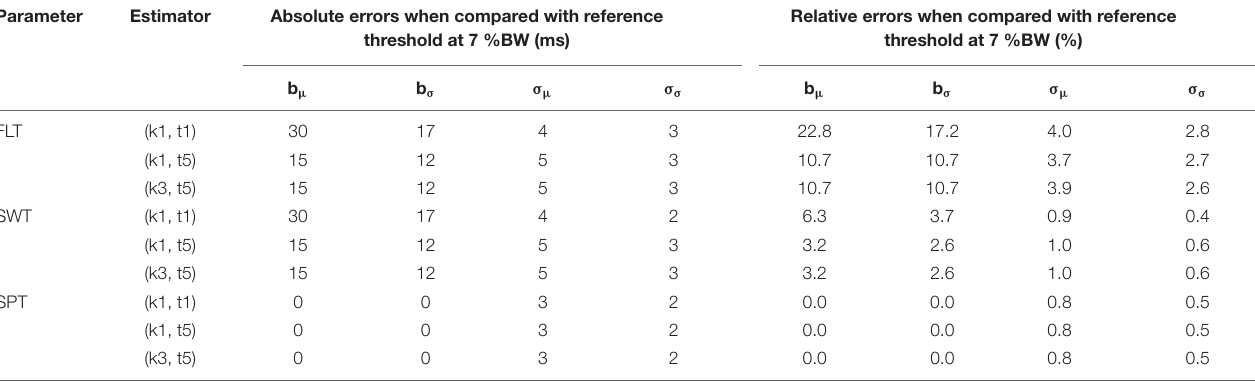
TABLE 4 | Flight phase duration (FLT), swing phase duration (SWT) and step time duration (SPT) estimations errors for the (k 1 , t 1 ), (k 1 , t 5 ) and (k 3 , t 5 ) candidates when a reference threshold at 7 %BW is used on the vertical GRF. Parameter